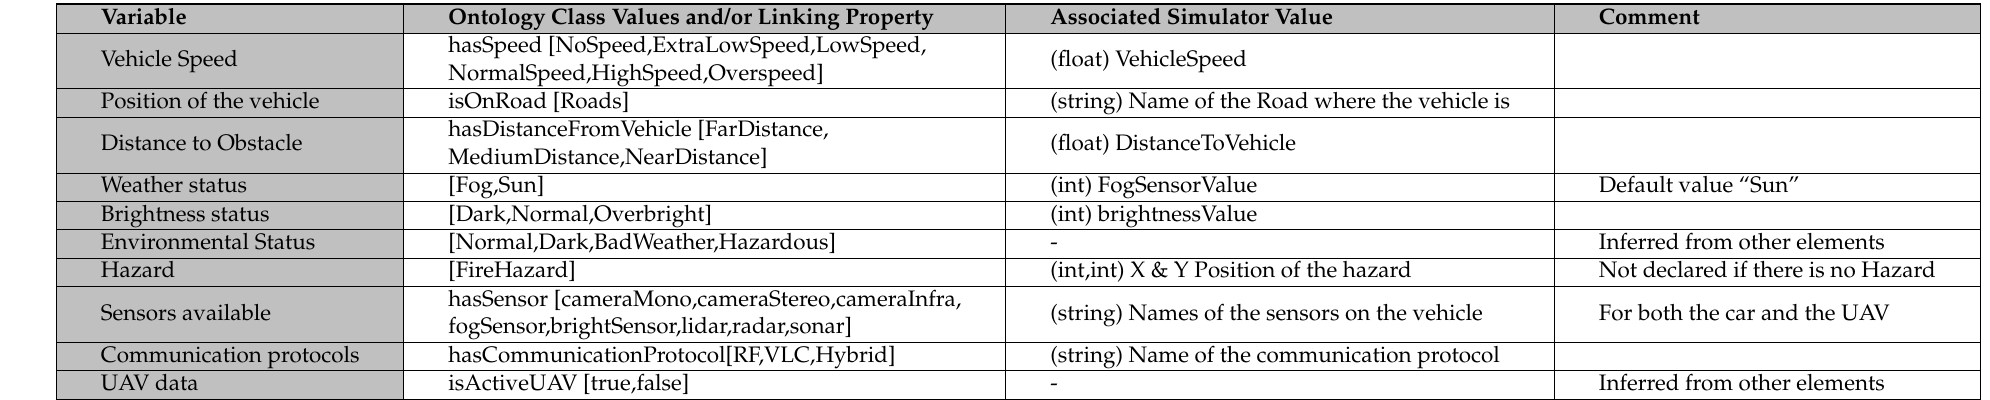
Table A3. Main classes of the ontology and their associated variables from the simulator. The virtual data generated by the experiments are sent to the ontology which classify and process them according to the declared properties and logical